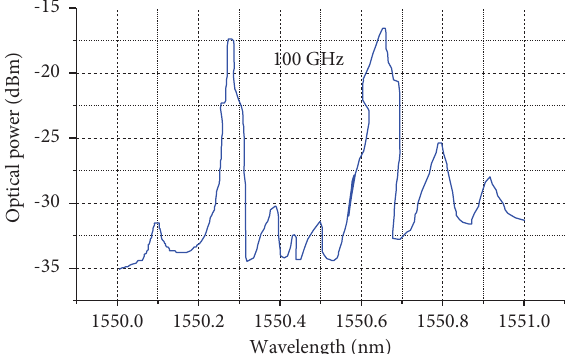
Figure 7: Optical power estimations at diferent